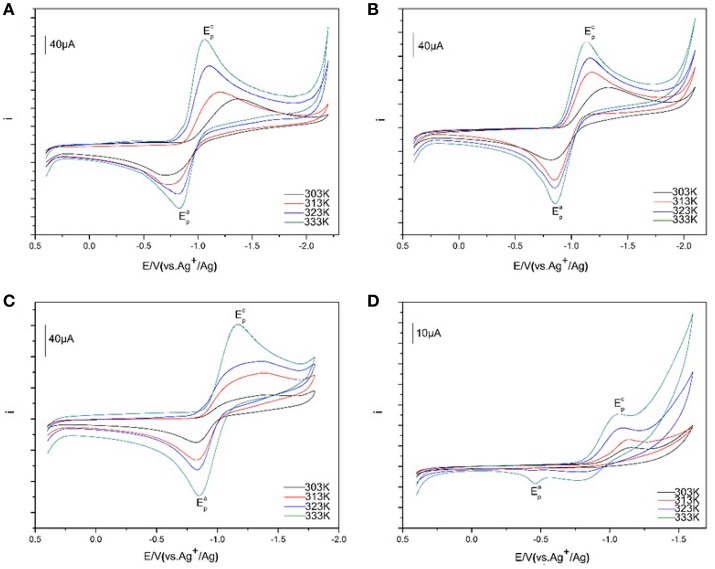
Cyclic voltammograms of Eu(III) in [C4mim][N(CN)2] (A), [C4m2im][N(CN)2] (B), N4442[N(CN)2] (C), and N8444[N(CN)2] (D) with Ag/AgCl as reference electrode at the scan rate of 100 mV/s from 303 to 333 K.